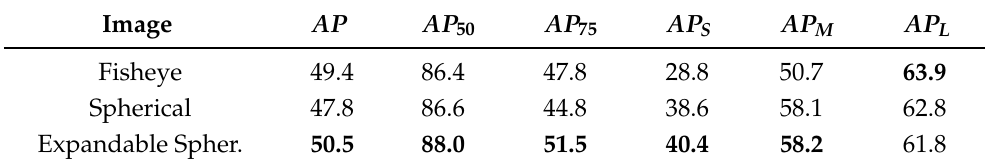
Table 15. Accuracy of different projections of LCat model on the Fisheye-Dongseongro.